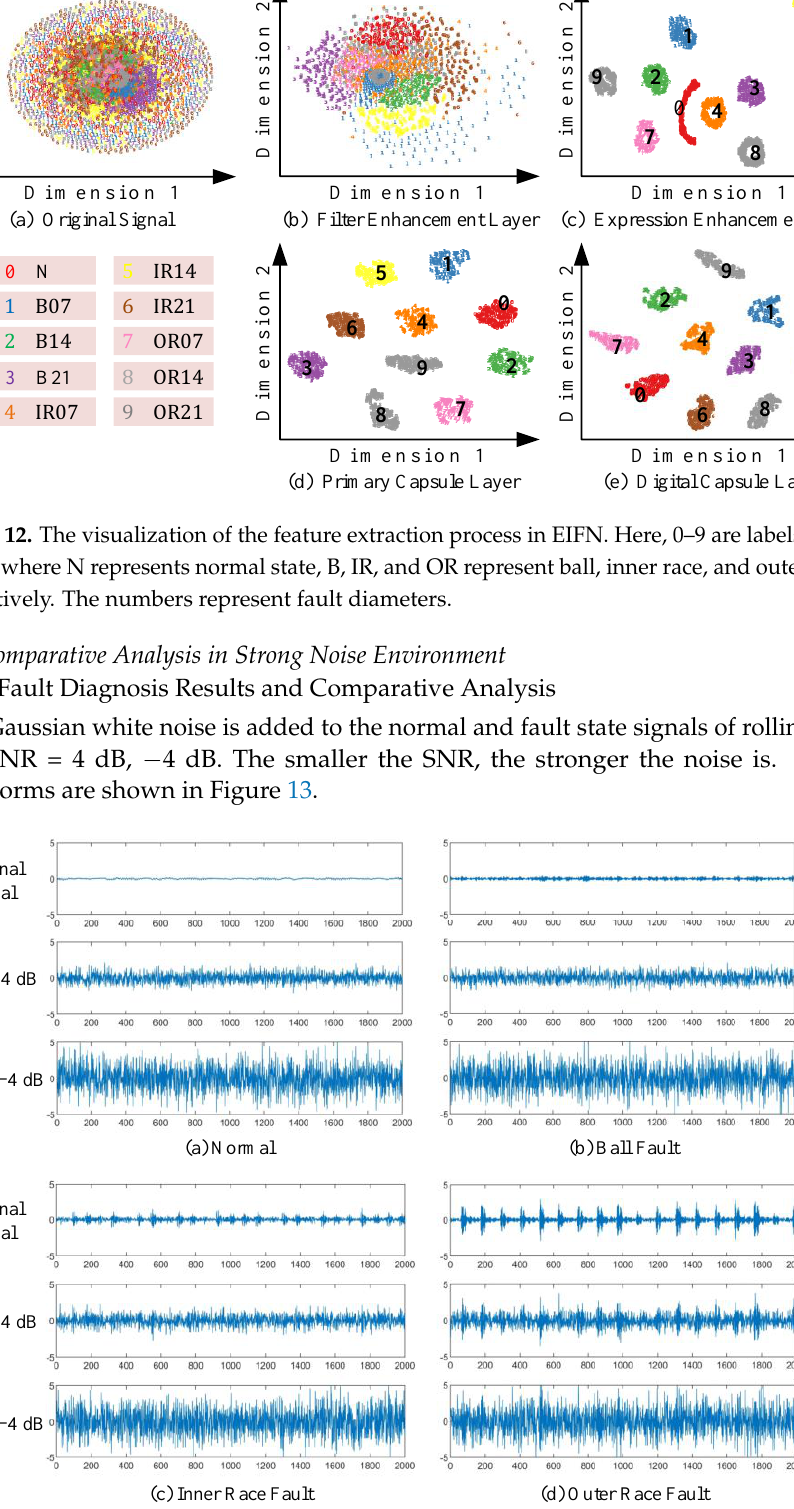
Figure 13. Original signal, the mixed signal with SNR = 4 dB, and the mixed signal with SNR = −4 dB in different fault state. The abscissa is the number of samples, and the ordinate is the amplitude.